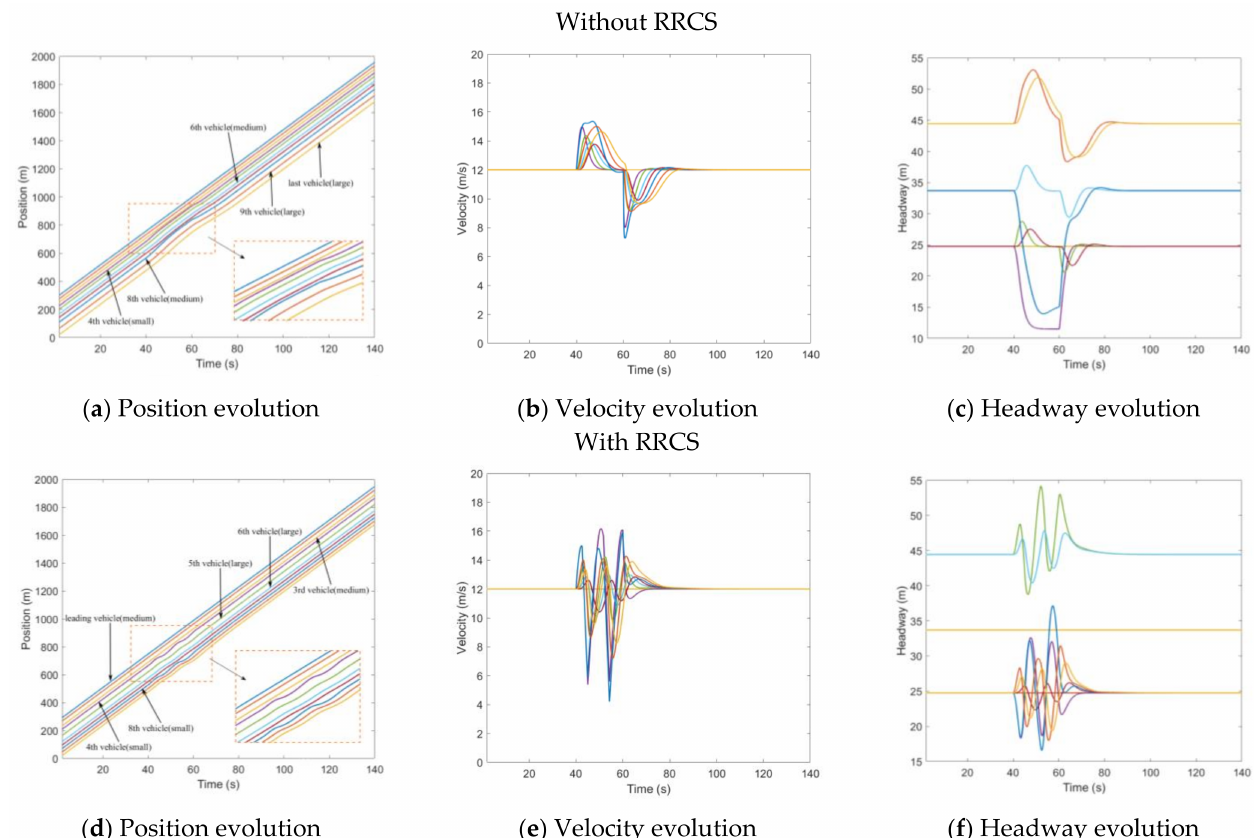
Figure 8. Mixed traffic flow evolution diagrams under collusion attacks (Type I) with/without